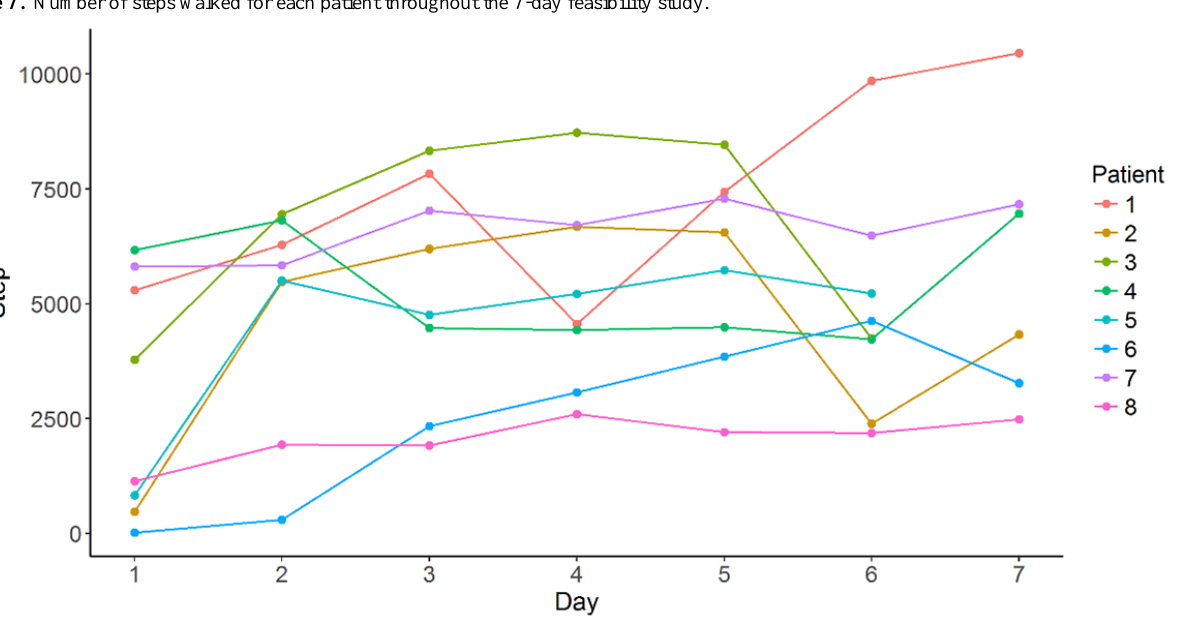
Figure 7. Number of steps walked for each patient throughout the 7-day feasibility